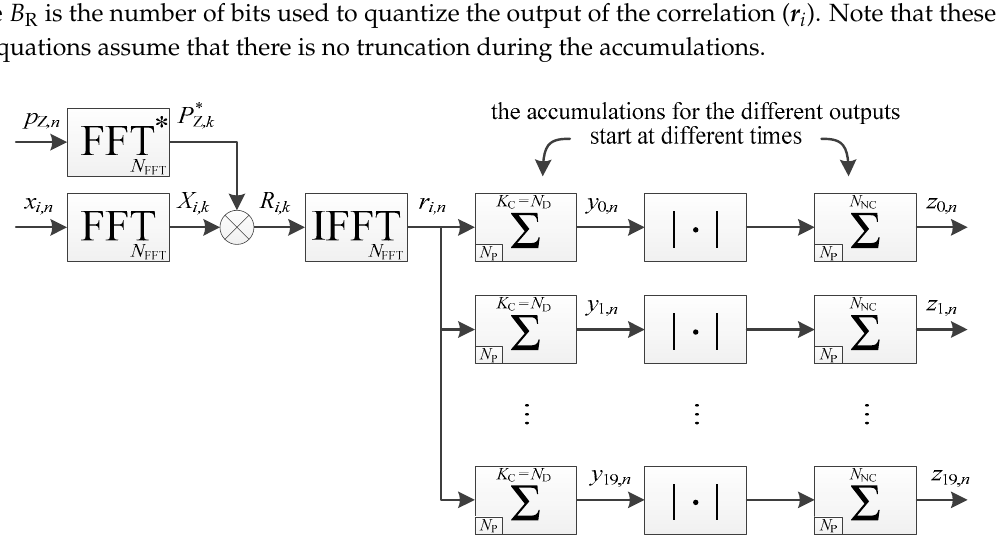
Figure 2. Implementation of a data channel acquisition (timing diagram available in Figure 3).